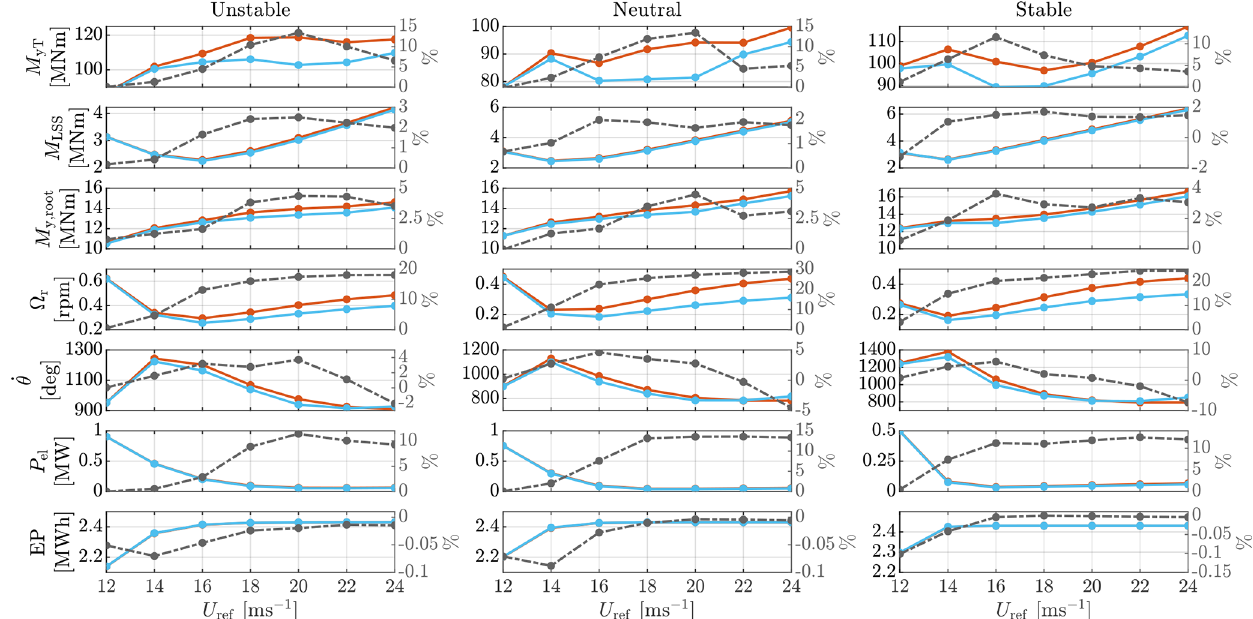
Figure 14. Comparison of DEL ( M yT , M LSS , M y , root ), SD ( (cid:127) r , ˙ θ , P el ), and EP, simulated using the Kaimal model. Note that the value of the relative reduction are reflected by the right-side y axis. Relative reduction: (FB-only–FFFB)/(FB-only).